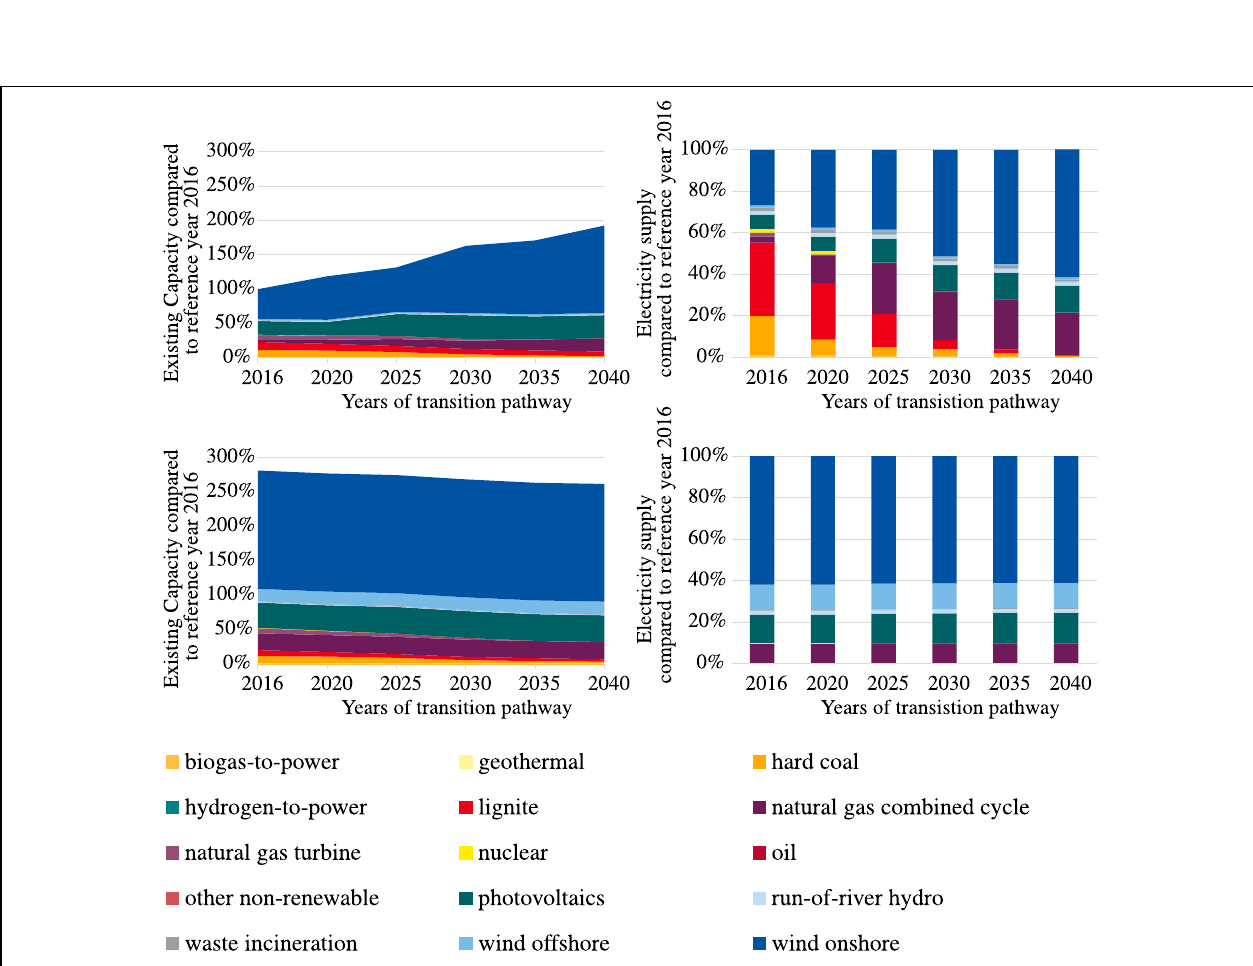
FIGURE 7 | Extended brownfield case with different objective functions: The upper figures show the cost minimal case, whereas the figures on the bottom show an environmental objective, where the global warming impact (GWI) of the system is minimized. The left column shows the optimized production processes for electricity generation compared to the reference year of 2016 in case study 3 ( Table 3 ). The right column shows the electricity production shares of the different production processes.